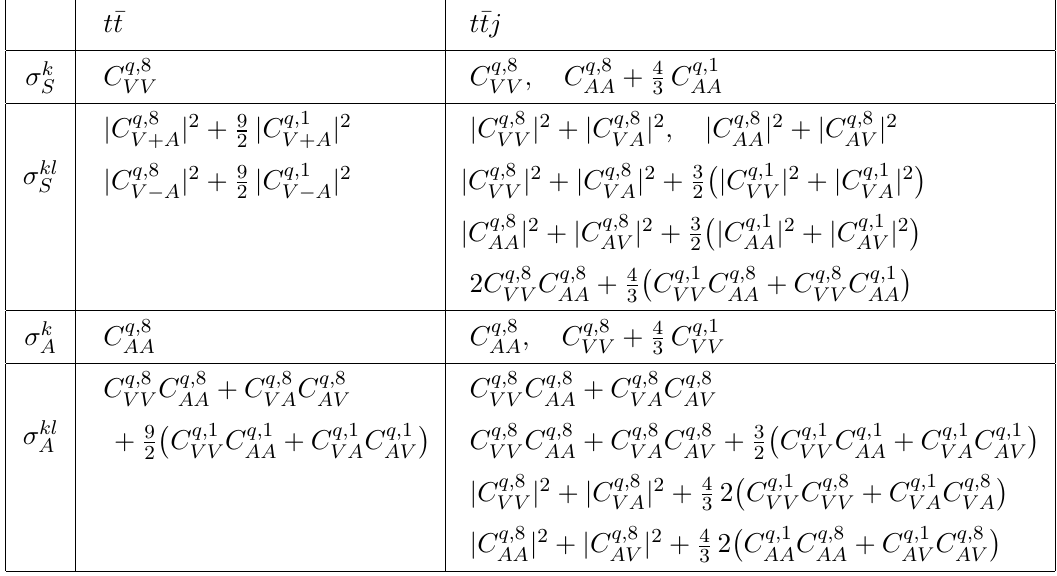
Table 3 . Four-quark operator contributions to t (cid:22) t production (left) and t (cid:22) tj production (right) at tree level at O ((cid:3) (cid:0) 2 ) and O ((cid:3) (cid:0) 4 ), denoted as (cid:27) k